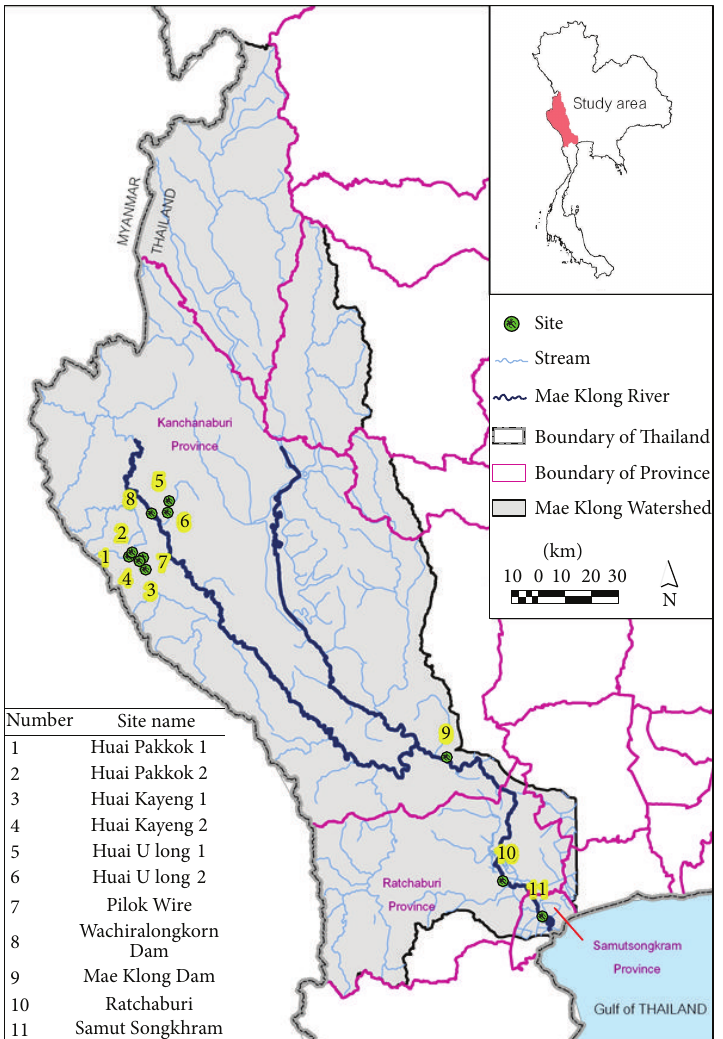
Figure 1: Map of Mae Klong Watershed showing the sampling sites, namely, Huai Pakkok, PK1 = 1 and PK2 = 2; Huai Kayeng, KY1 = 3 and KY2 = 4; and Huai U Long, UL1 = 5 and UL2 =